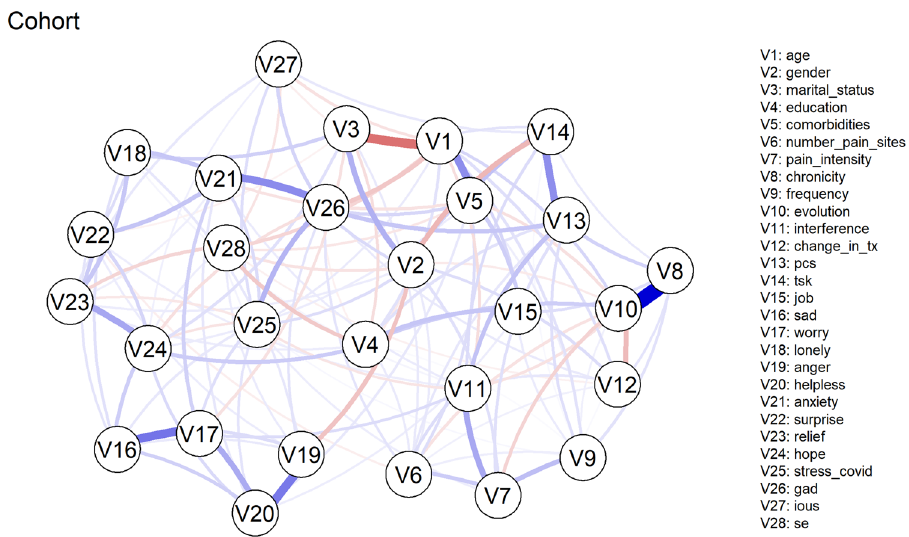
Figure 2. Network analysis of the entire cohort. Edges represent connections between two nodes and are interpreted as the existence of an association between two nodes, adjusted for all other nodes. Each edge in the network represents either positive regularized adjusted associations (blue edges) or negative regularized adjusted associations (red edges). The thickness and colour saturation of an edge denotes its weight (the strength of the association between two